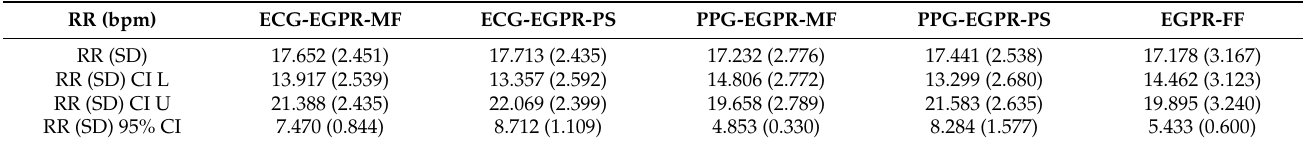
Table 5. We compare the CIs obtained using the ECG-based EGPR-MF, ECG-based EGPR-PS, PPG- based EGPR-MF, PPG-based EGPR-PS, and EGPR based feature fusion (FF); where U denotes upper limit and L denotes lower